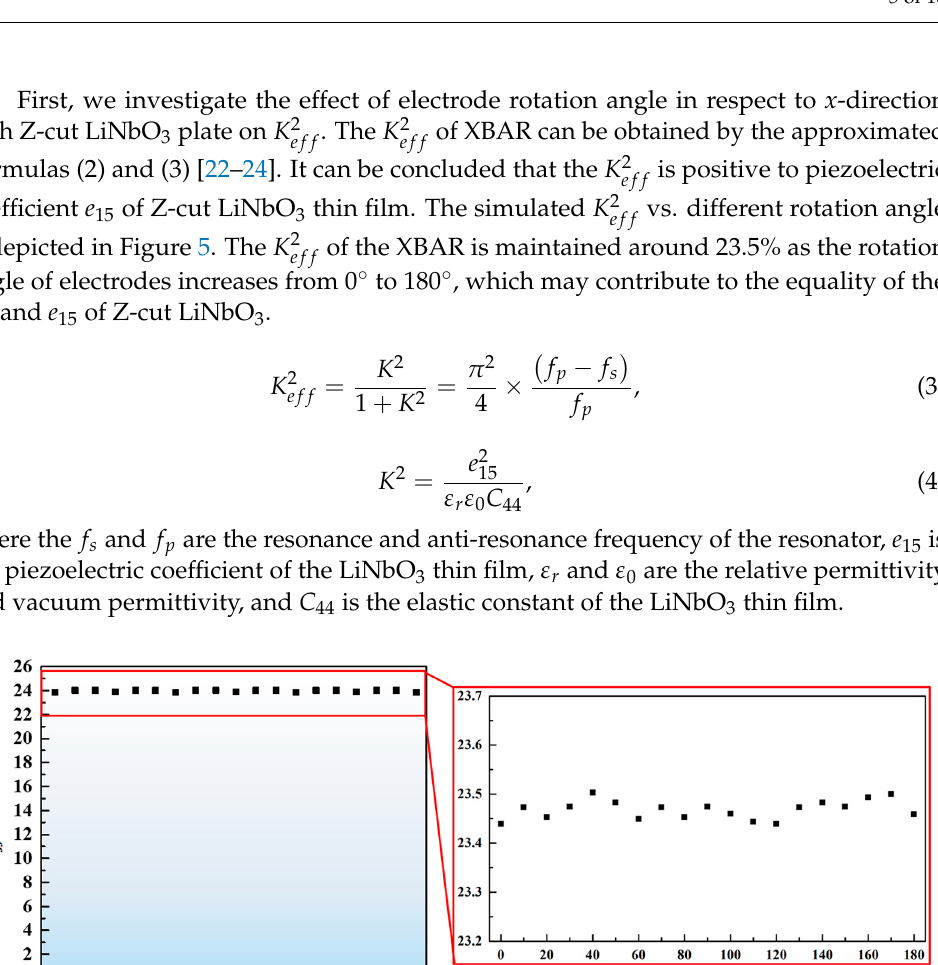
Figure 4. ( a ) The simulated impedance curve of resonator with pentagon spiral electrodes. ( b ) The simulated horizontal displacement mode shape at resonance frequency of A 1 mode along the A-A’ cross section and the horizontal displacement deformation in the B-B’ cross section.